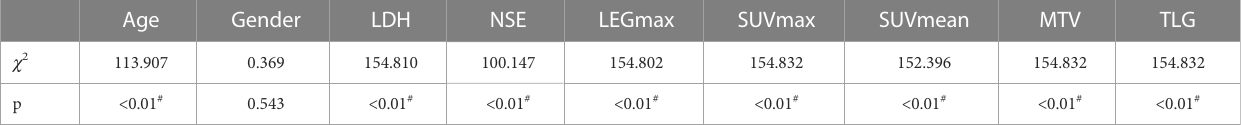
TABLE 7 Relationship of the age, gender and the levels of LDH, NSE and 18 F-FDG PET/CT metabolic parameters with PFS.